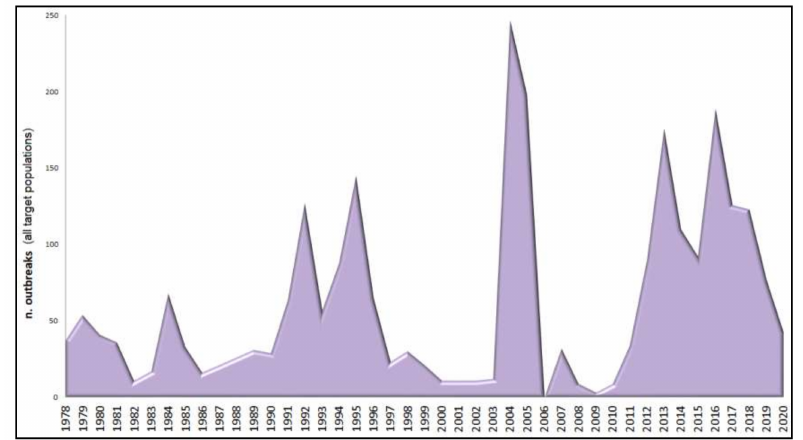
Figure 1. ASF outbreaks occurred in Sardinia in all the host populations of domestic pigs, wild boar, and free-ranging pigs between 1978 and 2020. Data are extracted from official reports recorded in the Italian National Information System for the Notification of Infectious Animal Disease (SIMAN) database, including both outbreaks confirmed for virus isolation and those for epidemiological cor- relation, according to the World Organization for Animal Health (OIE) Terrestrial Manual.